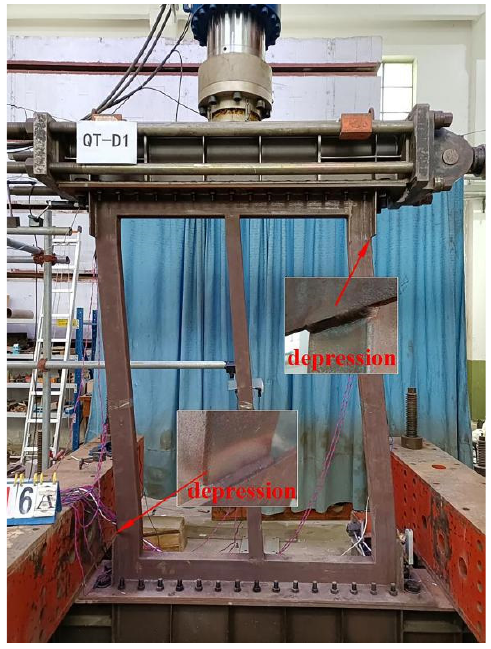
Figure 6. Failure image of QT − D1.